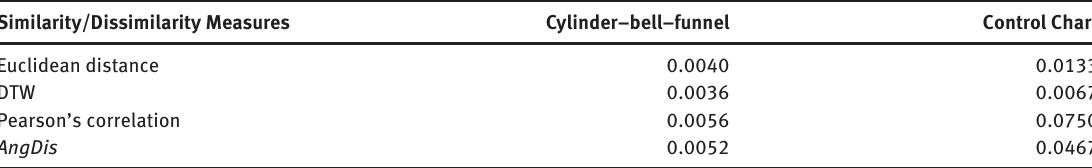
Table 1. Error Rates for Various